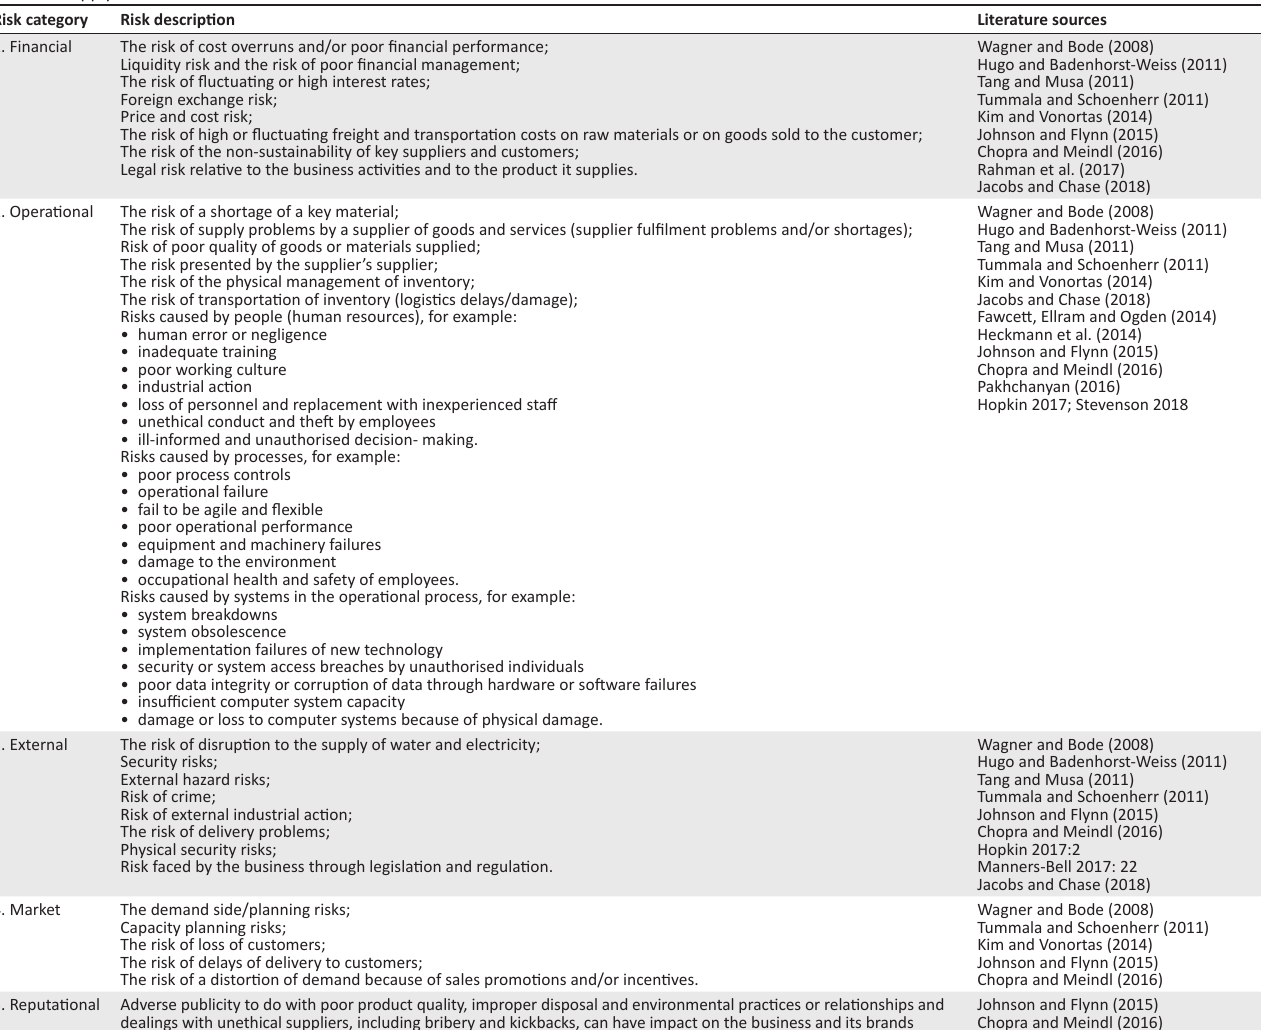
TABLE 1: Supply chain